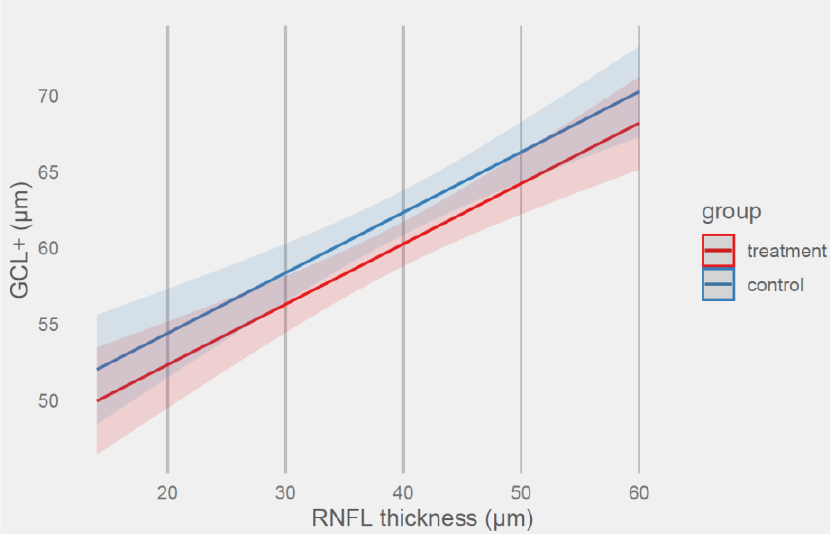
Figure 2. Prediction of retinal ganglion cell layer thickness (μm) by mod el 2 with RNFL thickness and group terms. and group